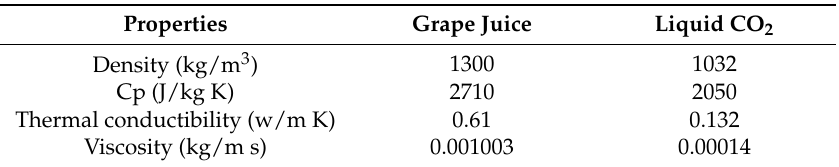
Table 1. Characteristics of the fluids.